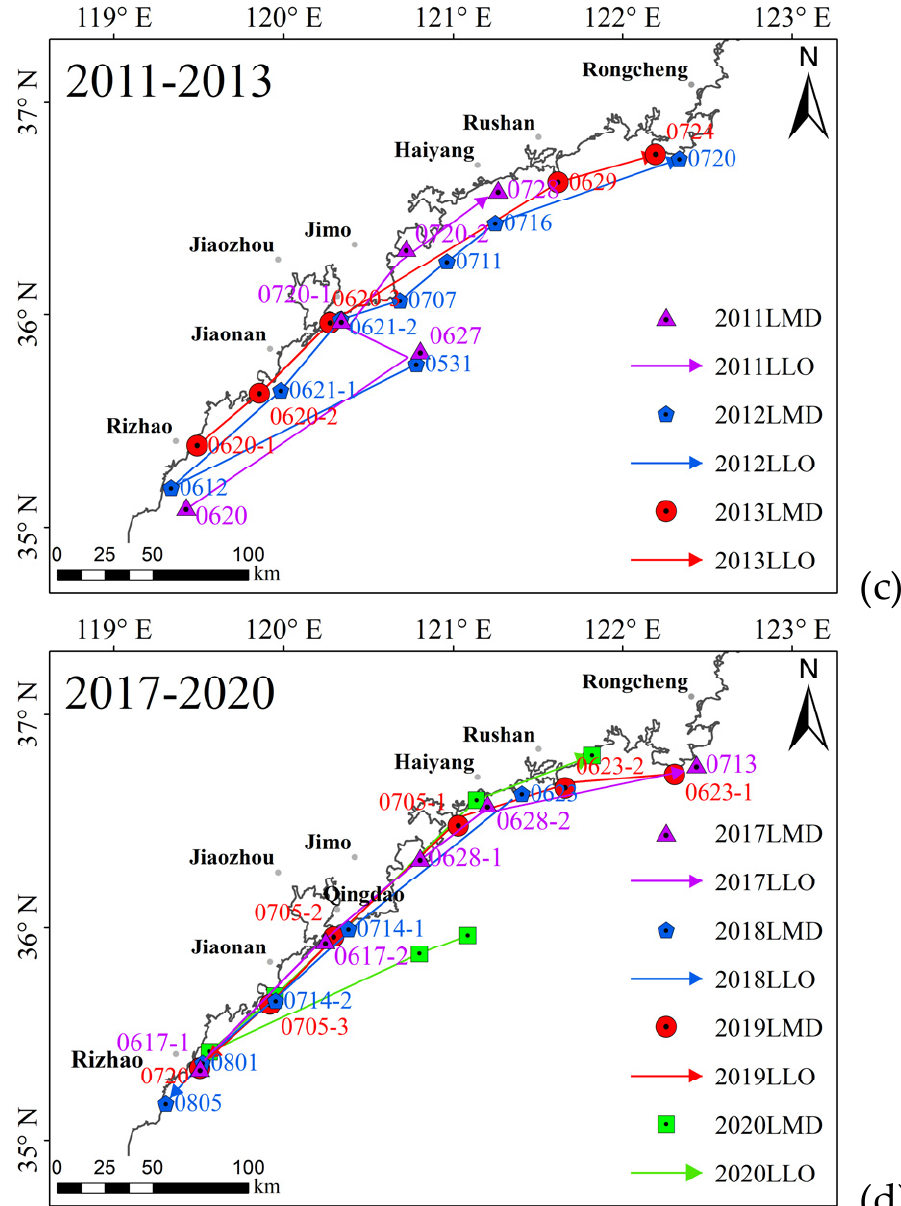
Figure 9. The LLO variation from 2008 to 2020. The number in figure represents month-date, e.g., 0725 is on July 25. The number after the date is not in sequence.